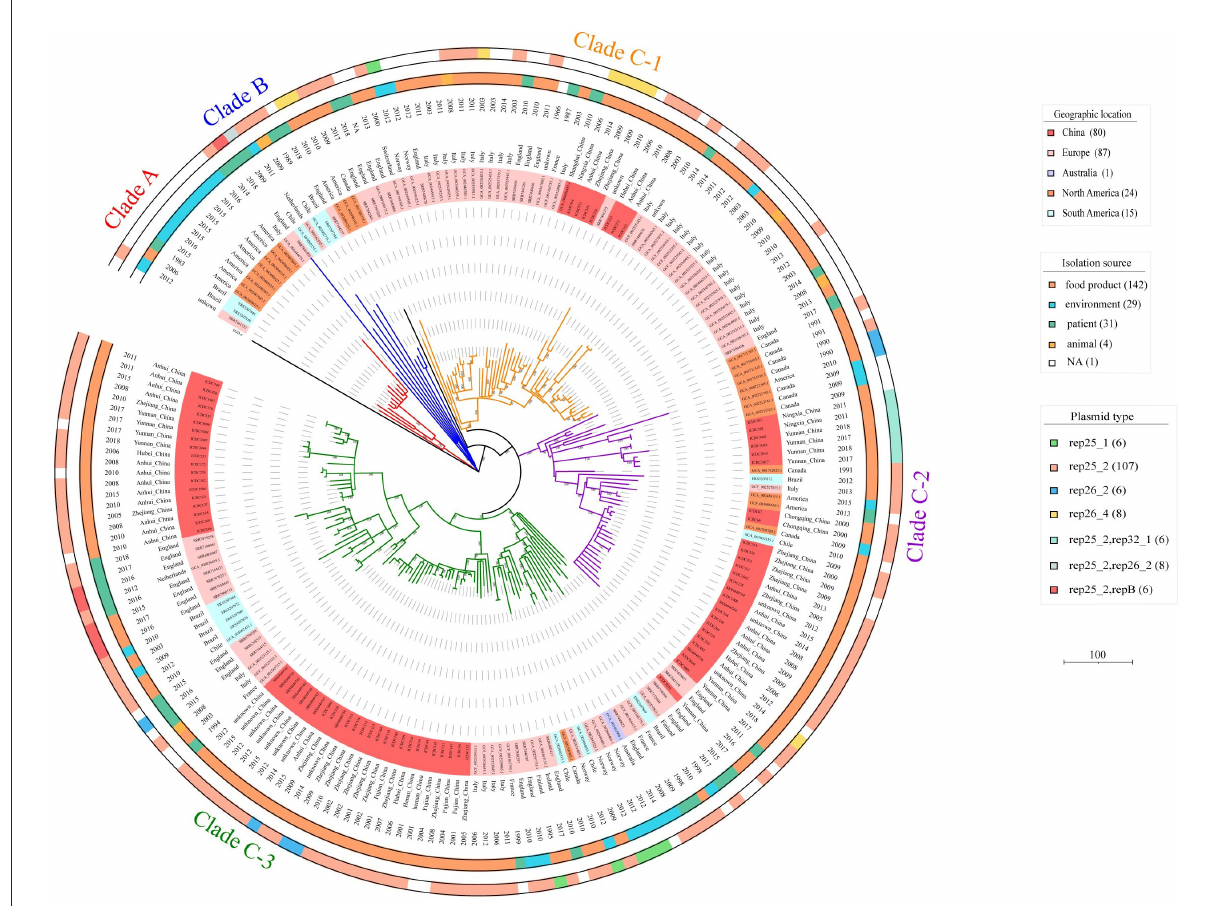
FIGURE1 Phylogenetic tree of the 207 ST9 isolates in this study. The tree based on core SNPs was constructed by MEGA, with 1,000 bootstrap replicates. Branches are colored by phylogenetic Clade (Clade A, red; Clade B, blue; Clade C-1, orange; Clade C-2, purple; Clade C-3, green). The geographic location, date of isolation, isolation source, and the plasmid type of the isolates are shown on the tree (from inner to outer circles), according to the color legend shown on the